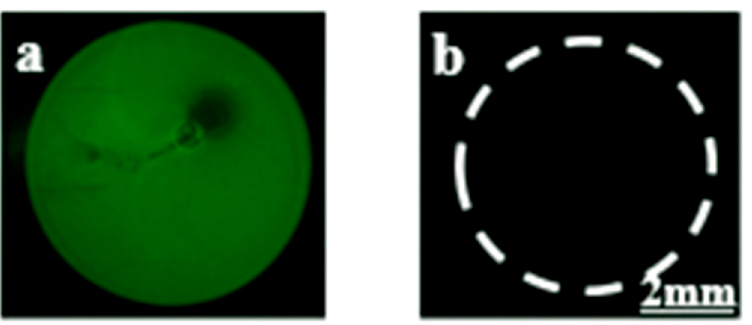
Figure 4. Fluorescence images showing ( a ) AuNPs–PDMS stamp surface with a circular region of immobilised RNA probe (3’ 6-FAM-conjugated Apt 8), and ( b ) DMOAP-coated glass slide surface after µCP. The RNA probe is stable and not transferred from the stamp to the DMOAP-coated glass slide during µCP.